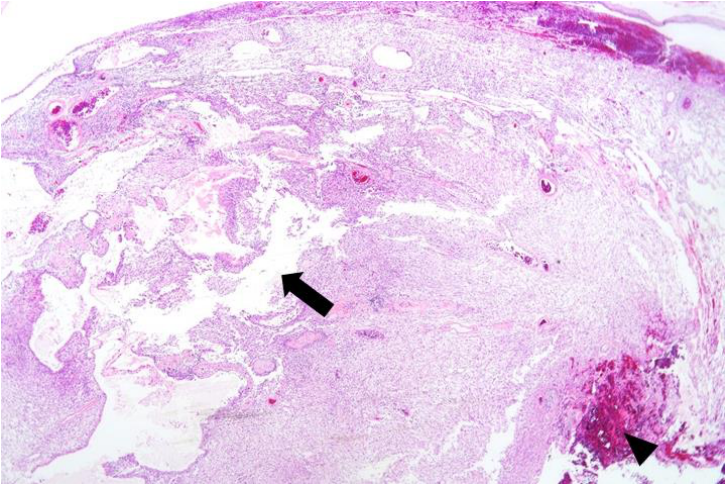
Figure 2. Lower magnification shows a well-defined and capsulated round mass with intratumoral cystic changes (arrow) and hemorrhage (arrowhead) (H-E stain, 20× magnification).